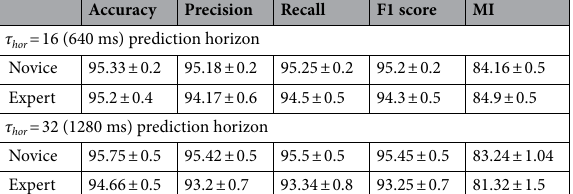
Table 1. Average performance [%] of the expert and novel models as a function of prediction horizon, tested on 10 sets of N test = 2000 samples. MI Mutual